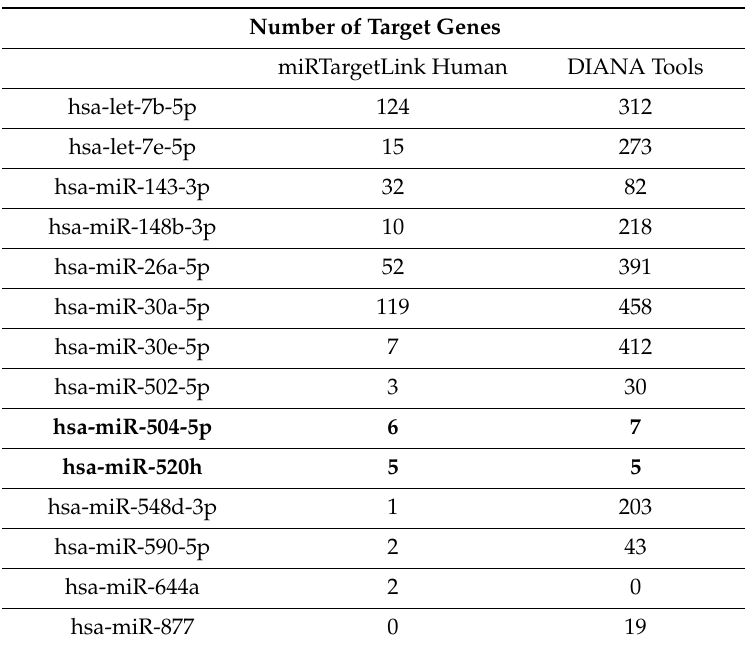
Table 2. Bioinformatics tools for in silico analysis.